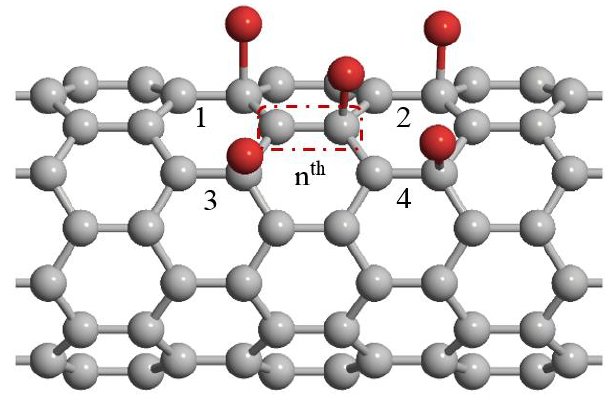
Figure 3. Configuration of adsorbed molecules on the ZCNT surface.